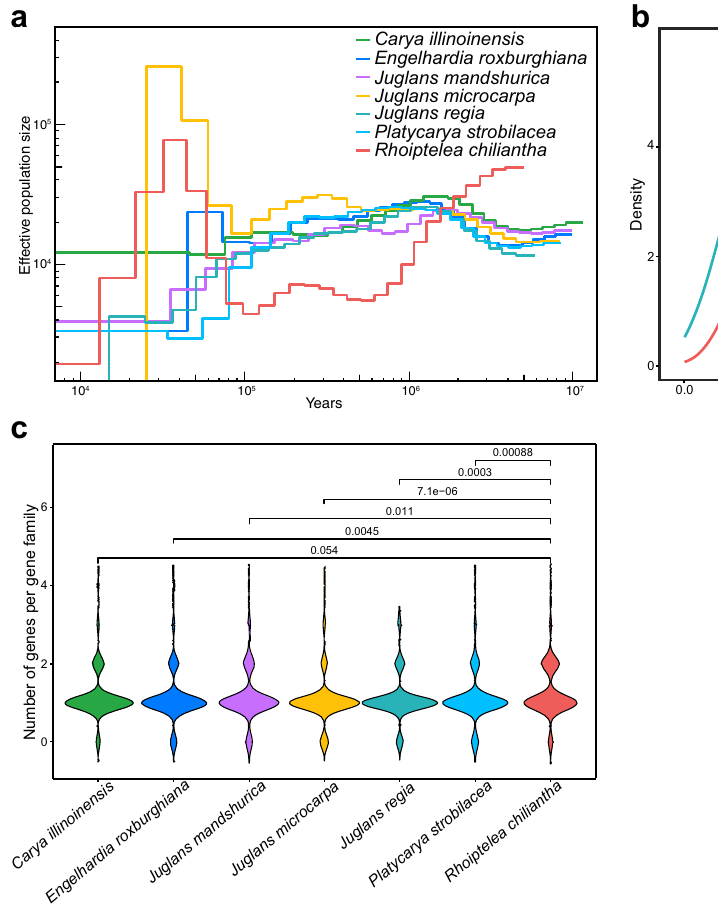
Fig. 4 | Effective population sizes and the number of genes in gene families associated with DNA repair and recombination. a Effective population sizes of the seven Juglandaceae species estimated by PSMC. b The K a / K s distribution for R. chiliantha (red) and J. regia (blue). K a / K s is evaluated as the expected number of substitutions per synonymous site between the focal species and its common ancestorwiththeotherspecies.Thetwo-tailedtwo-sampleWilcoxonrank-sumtest